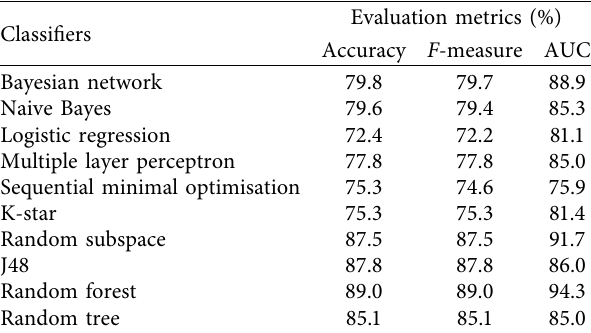
Table 1: Evaluation metrics of ten classifiers in predicting the anxiety and depression among elderly